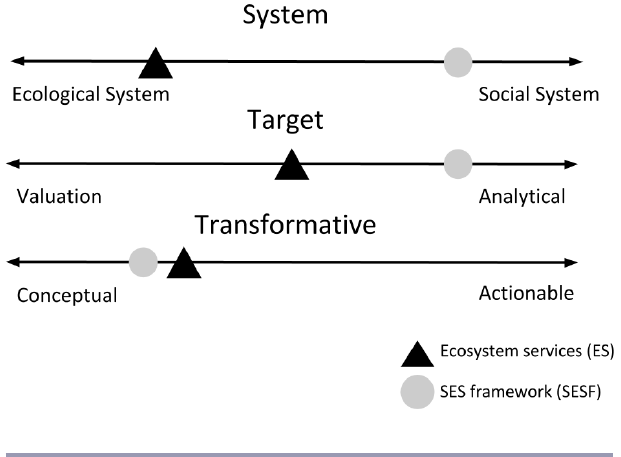
Fig. 3 . Conceptual orientation of the ecosystem services concept and the social-ecological systems framework showing their generalized contributions to generating each type of knowledge. Each approach is crudely placed on the scale of each knowledge type as an interpretation of their